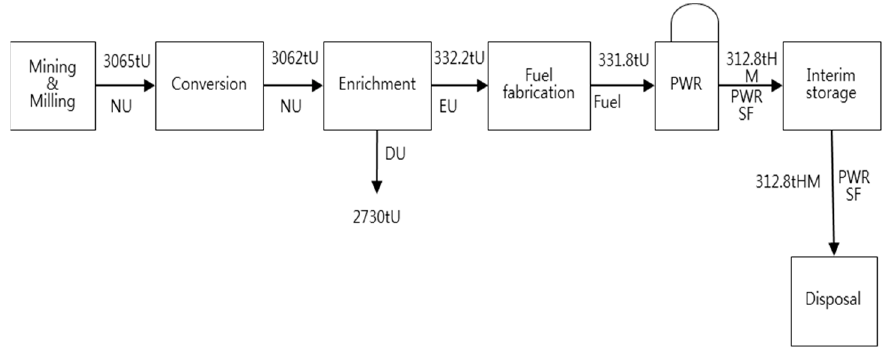
Figure 2. Material flow of direct disposal. Here, NU = natural uranium, DU = depleted uranium, EU = enriched uranium, PWR SF = pressurized-water reactor spent nuclear fuel.